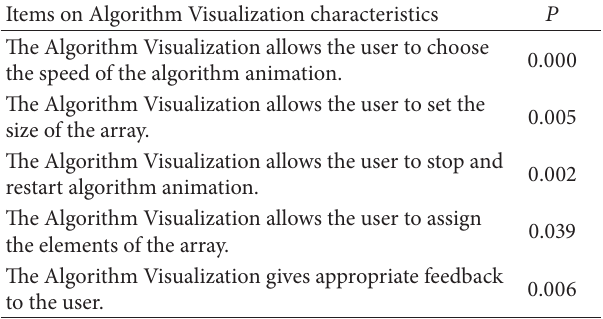
Table 3: Differences in the assessment of AV characteristics of the two groups.